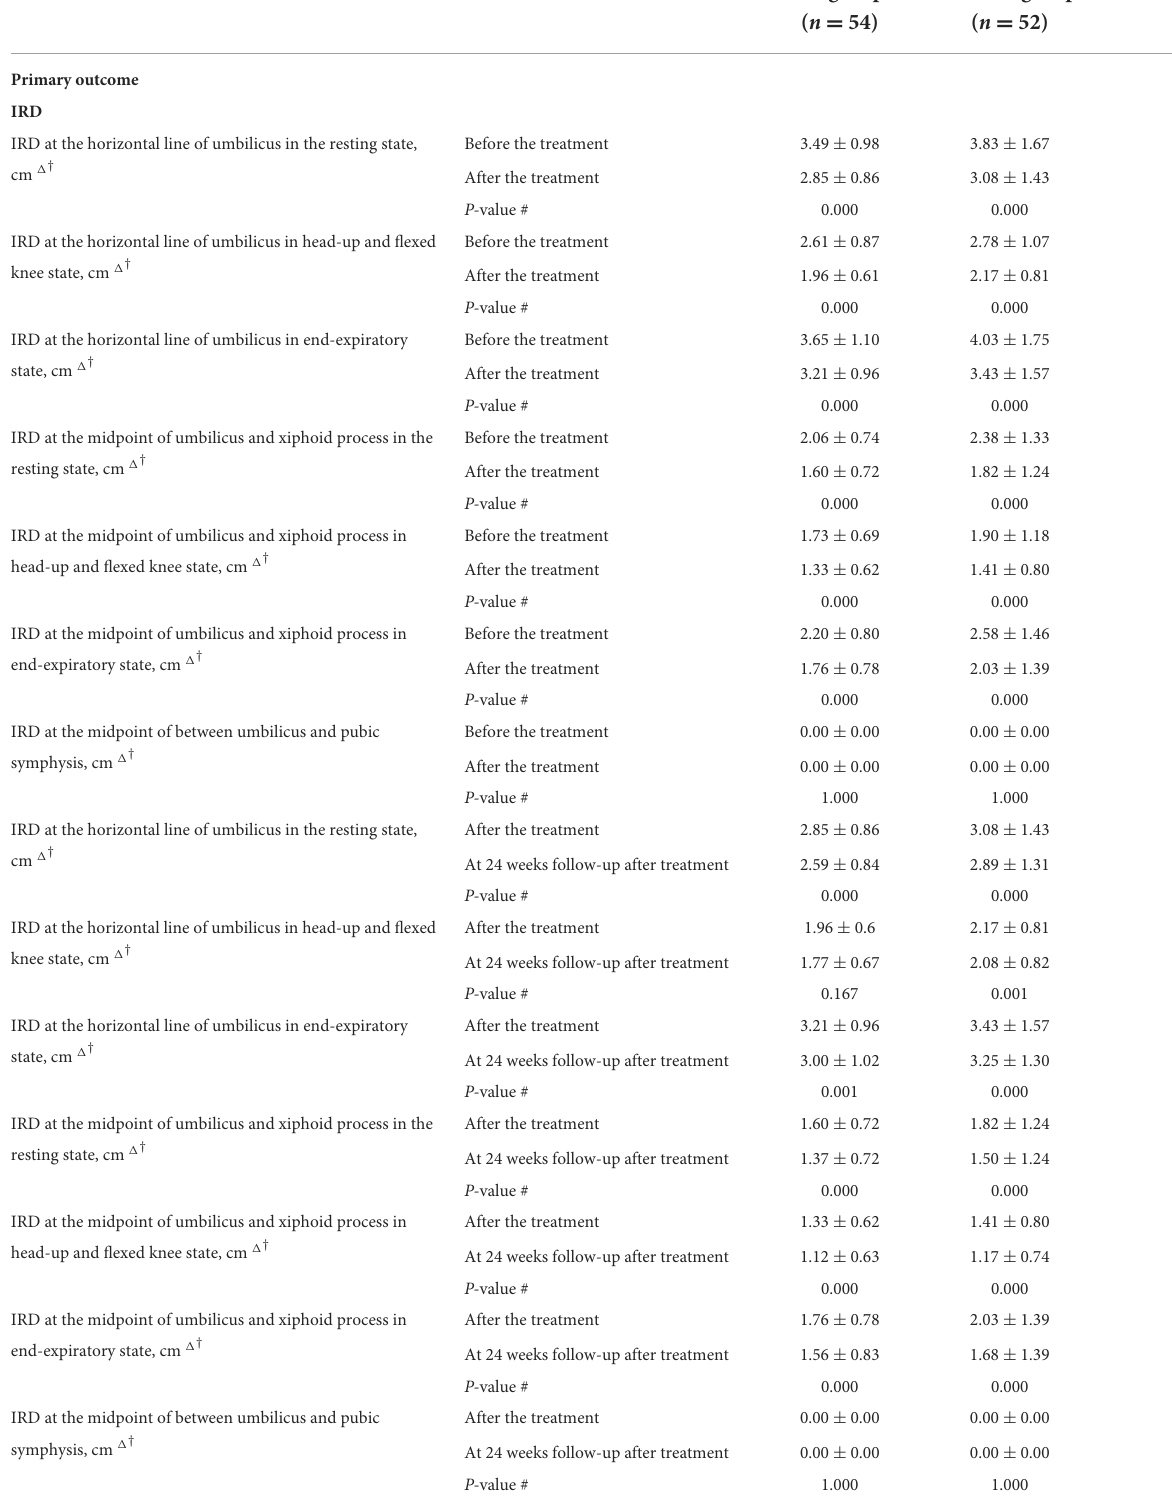
TABLE 4 Primary and secondary outcomes *